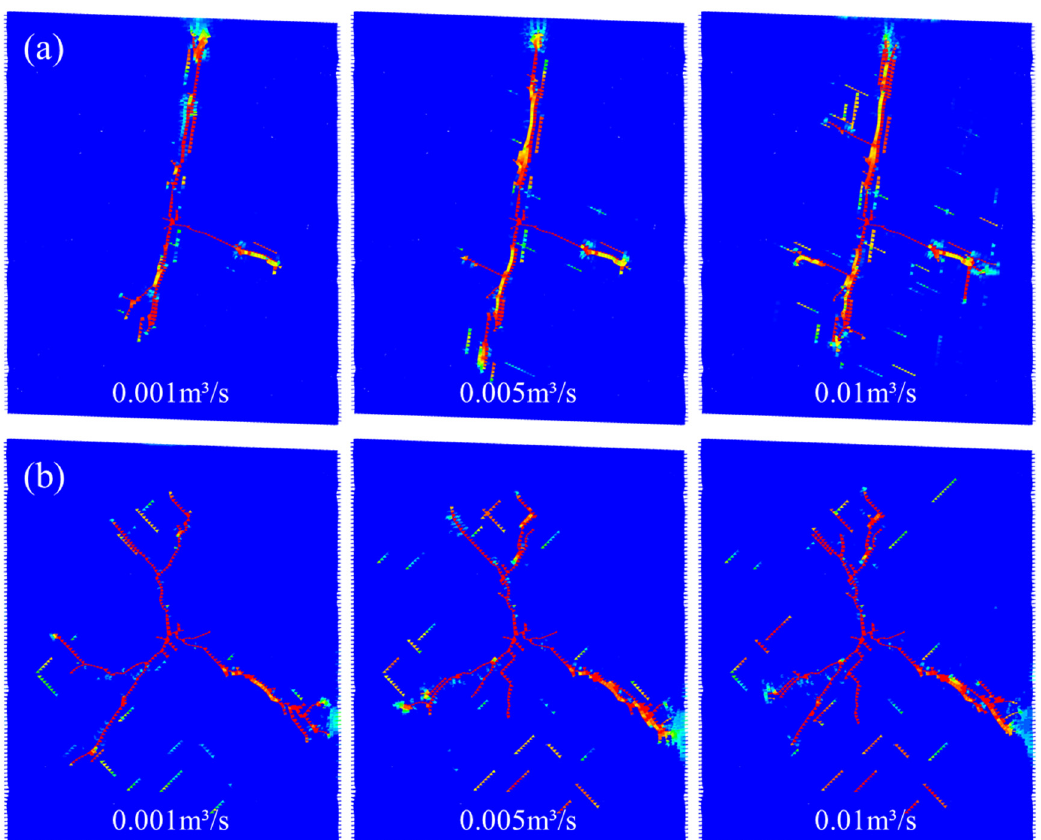
Figure 10. Results of fracturing group A ( a ) and group B ( b ) under different inject rates. First line in subfigures represent the results of natural fracture group A and second line is group